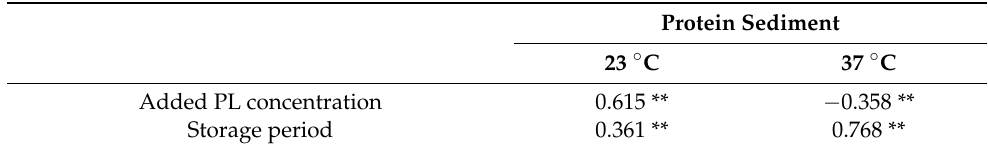
Table 2. Pearson correlation coefficients for the relationship between added PL concentration, storage period, and protein